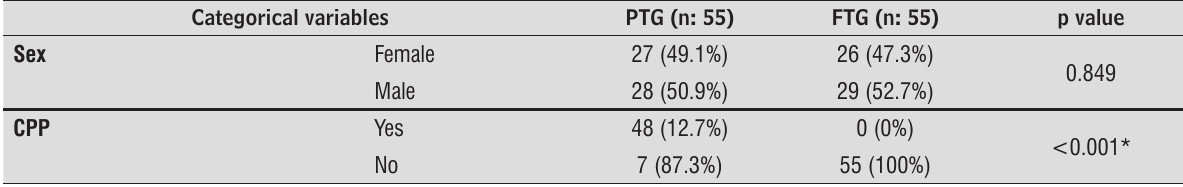
Table 2 - Characteristics of the study participants according to categorical variables Categorical